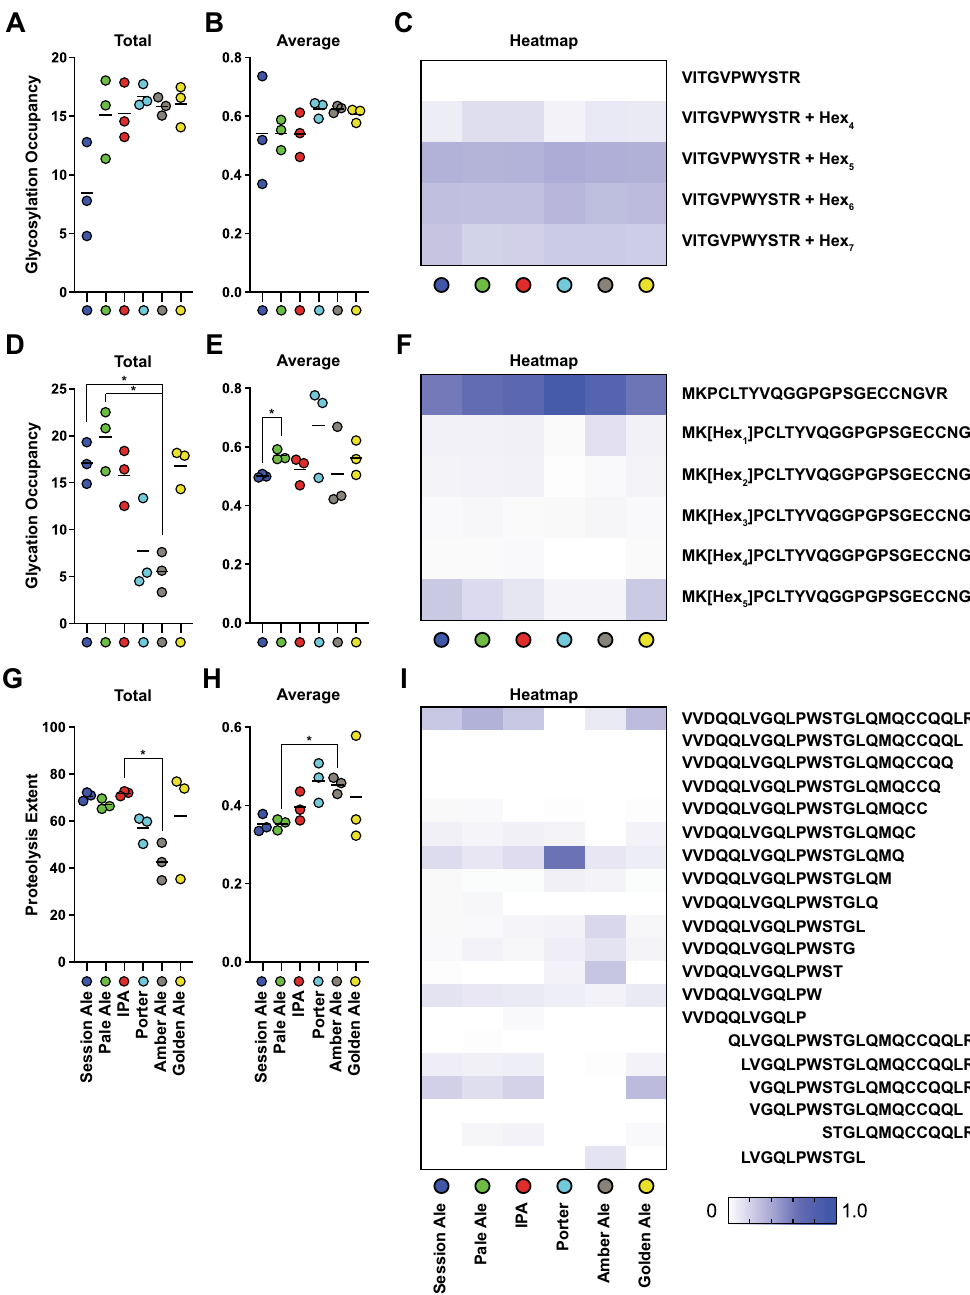
Figure 4. Site-specific occupancy and overall extent of PTMs in beers from Newstead Brewing Co. ( A ) Total and ( B ) average glycosylation occupancy. ( C ) Heat map of normalised abundance of unmodified and glycosylated forms of tryptic peptide R-V 94 ITGVPWYSTR 104 -L from Pau15. Hex modification location was not determined. ( D ) Total and ( E ) average glycation occupancy. ( F ) Heat map of normalised abundance of unmodified and glycated forms of tryptic peptide K-M 36 KPCLTYVQGGPGPSGECCNGVR 58 -S from NLTP1. ( G ) Total and ( H ) average extent of proteolysis. ( I ) Heat map of normalised abundance of unmodified and proteolytically cleaved forms of full tryptic peptide R-V 56 VDQQLVGQLPWSTGLQMQCCQQLR 80 -D from GLT3. Column graphs were of either total of average PTM occupancy/extent, calculated as either sum or average of all modified peptides normalised to their peptide family, respectively. Heat maps show modified peptides normalised to their peptide family. Bars show mean, n = 3, Error bars show SEM, * indicates statistically significant ( p <